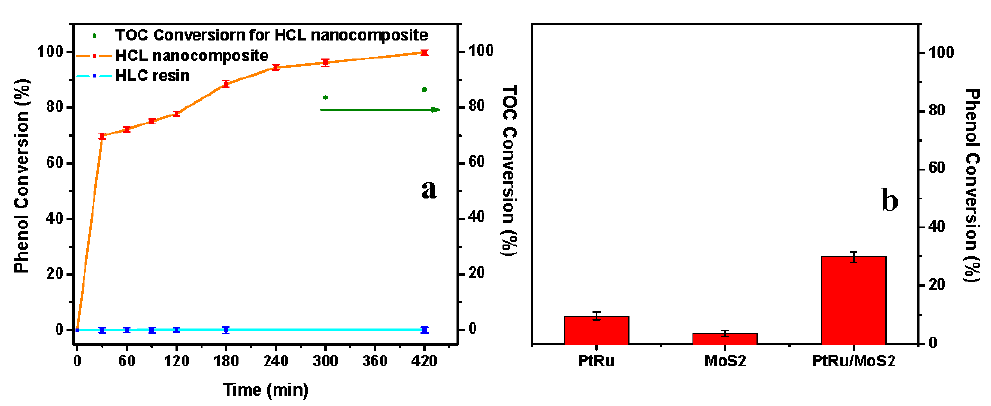
Figure 9. ( a ) Results of CWAO phenol oxidation with HCL resin and HCL nanocomposites. Reaction